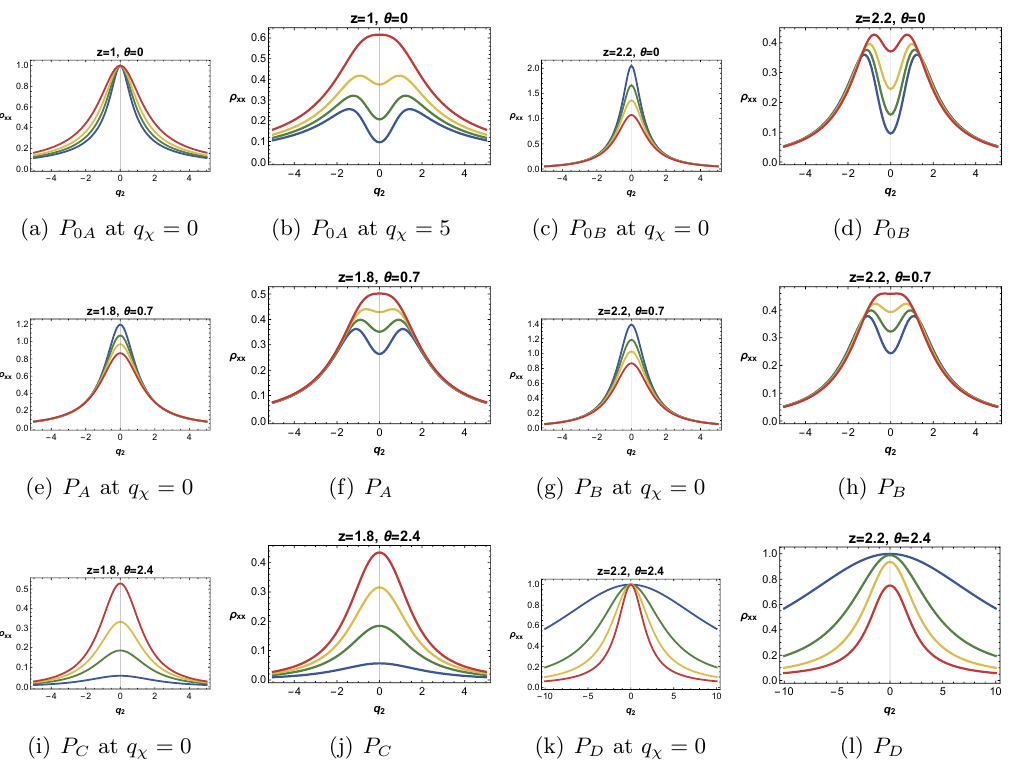
Figure 18 . Temperature evolution for (cid:26) xx ( q 2 ) for various ( z; (cid:18) ). Curves correspond to T = 0 : 04 ; 0 : 1 ; 0 : 16 ; 0 : 24 for blue, green, yellow, and red respectively. In all (cid:12)gure, q (cid:31) = 5 unless it is speci(cid:12)ed.